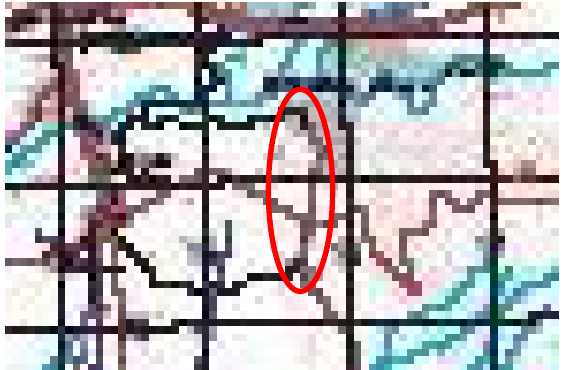
Figure 4. Connected roads with different qualities